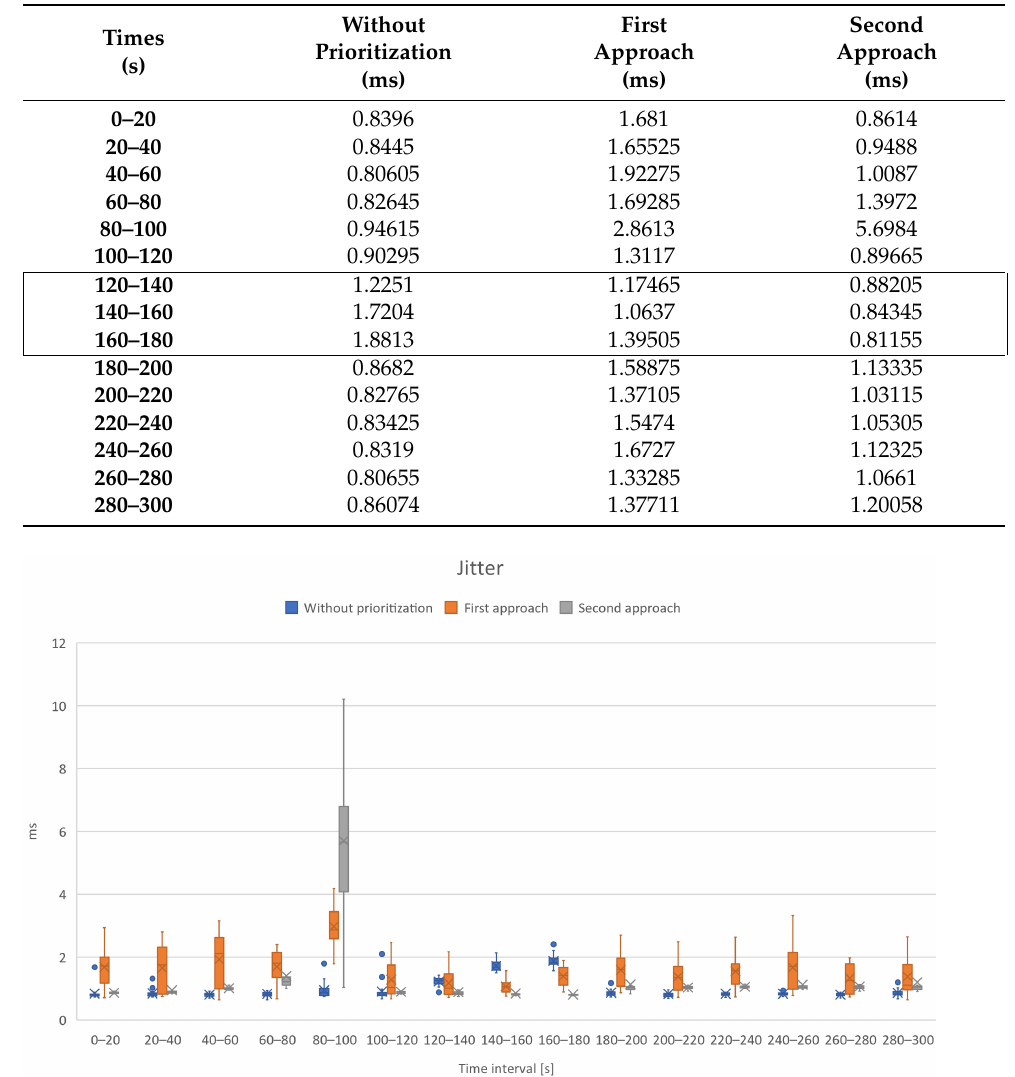
Figure 13. Comparison of the jitter obtained between the approaches considered (Streaming traffic